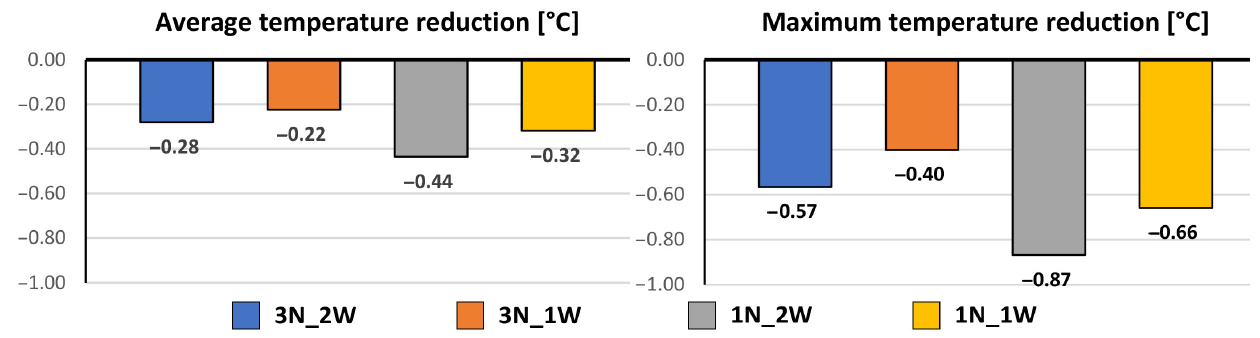
Figure 5. Average and maximum indoor air temperature reduction (°C) for the different configura- tions of the industrial building, considering summer reference week.